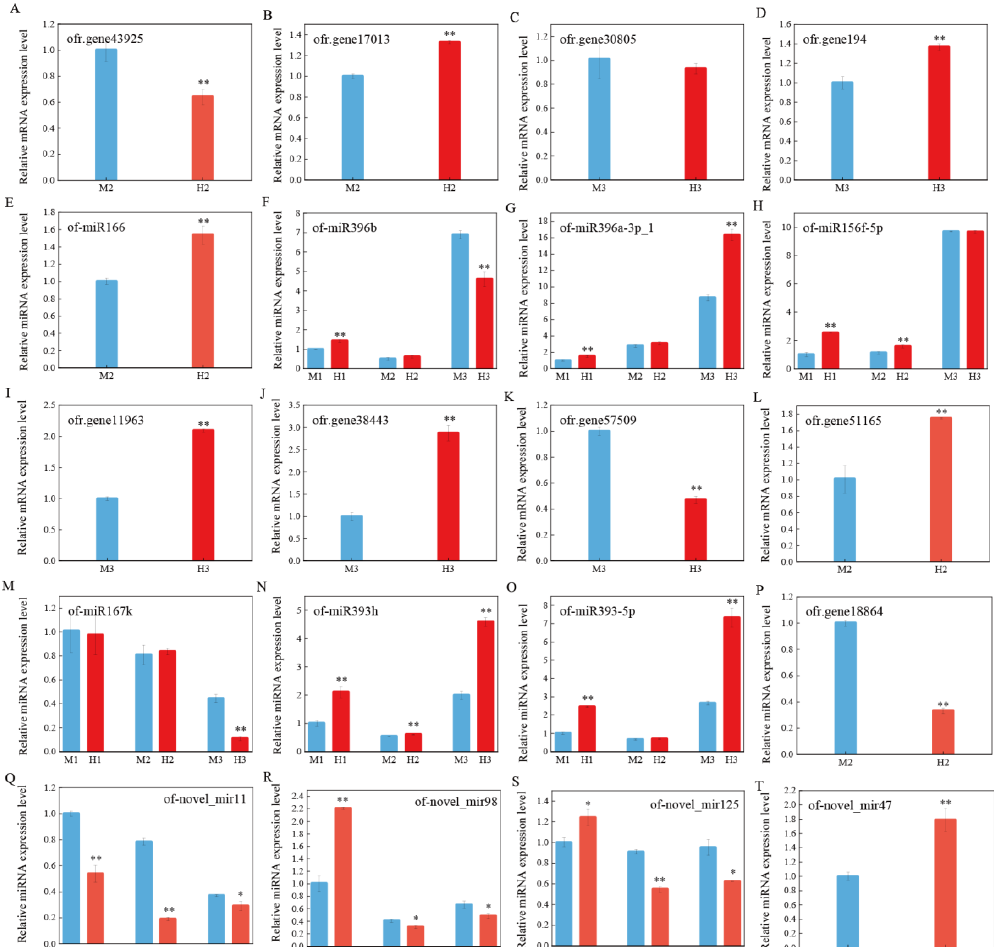
Figure 5. qRT-PCR validation of miRNAs and target gene expression levels at different stages. As- terisks indicate significant differences , as determined by Student’s t -test (** p < 0.01 or * p < 0.05). ( A – T ) represents the relative expression levels of mRNA or miRNA at different stages, respectively.